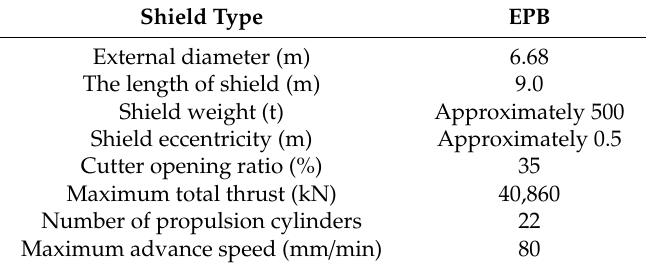
Figure 16. Cutterhead and advance system of shield: ( a ) shield cutterhead; and ( b ) shield cylinder partition. Table 2. Summary of the main specifications for the